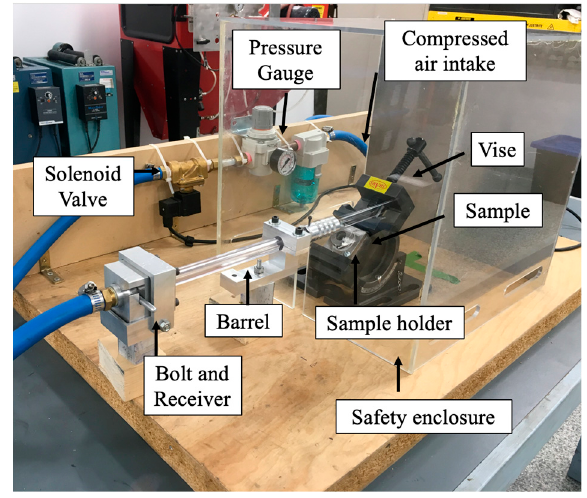
Figure 1. Single particle erosion apparatus.